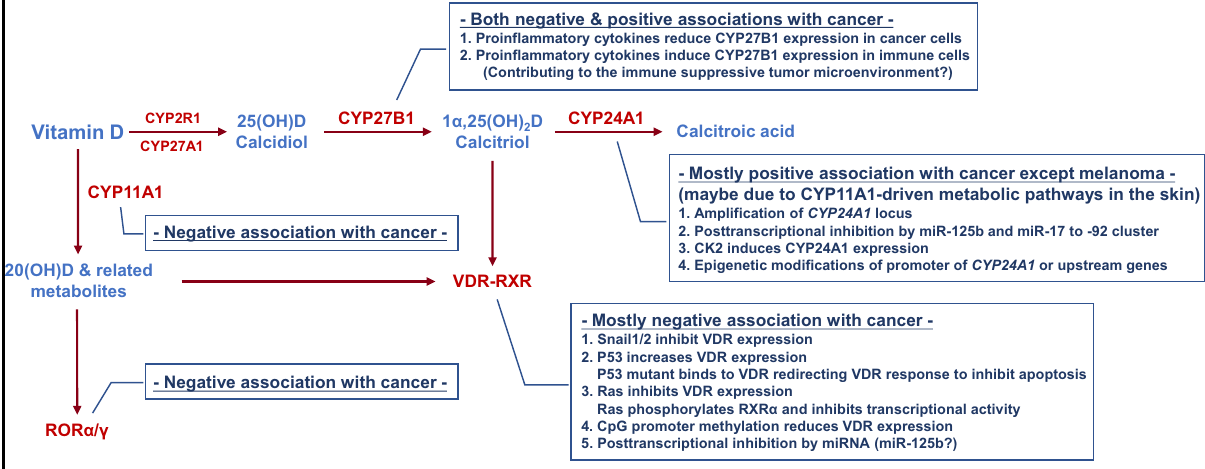
Fig. 4 Dysregulation of vitamin D metabolism in